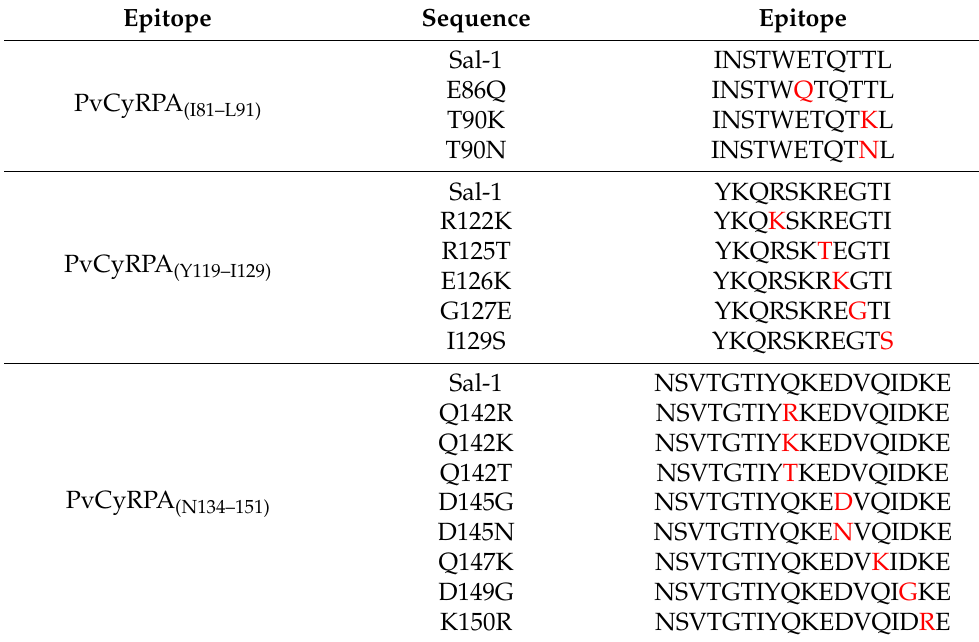
Table 6. Predicted B cell epitopes of PvCyRPA and related